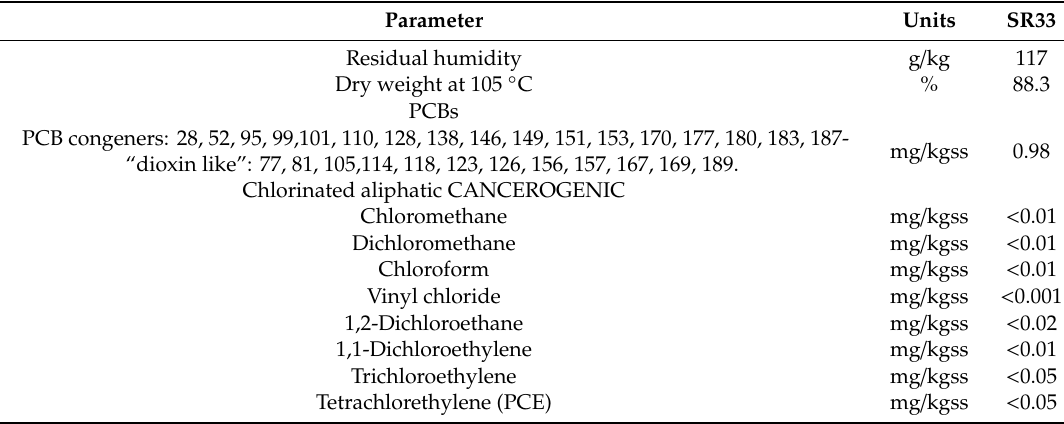
Table 10. Result of DNAPL for the SR33 soil